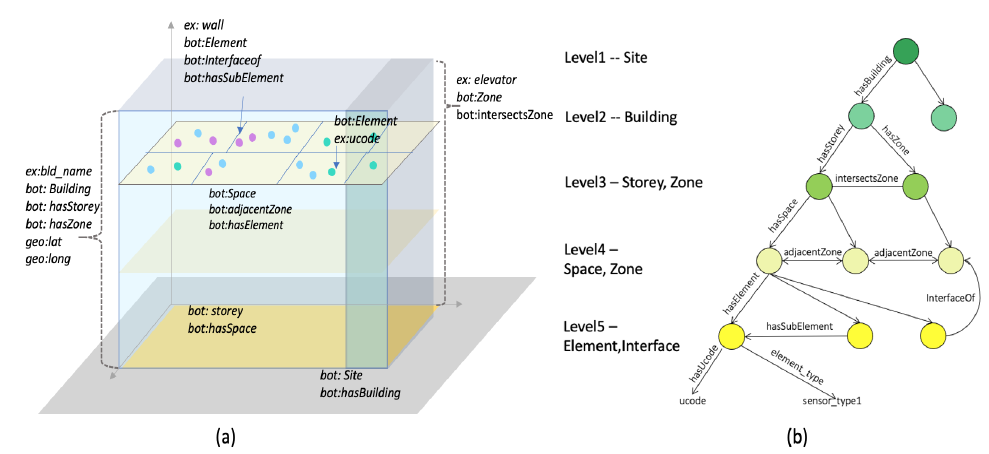
Figure 4. ( a ) Classes and relationships involved in the Building Topology Ontology; ( b ) The hierarchy of entities and relationships in